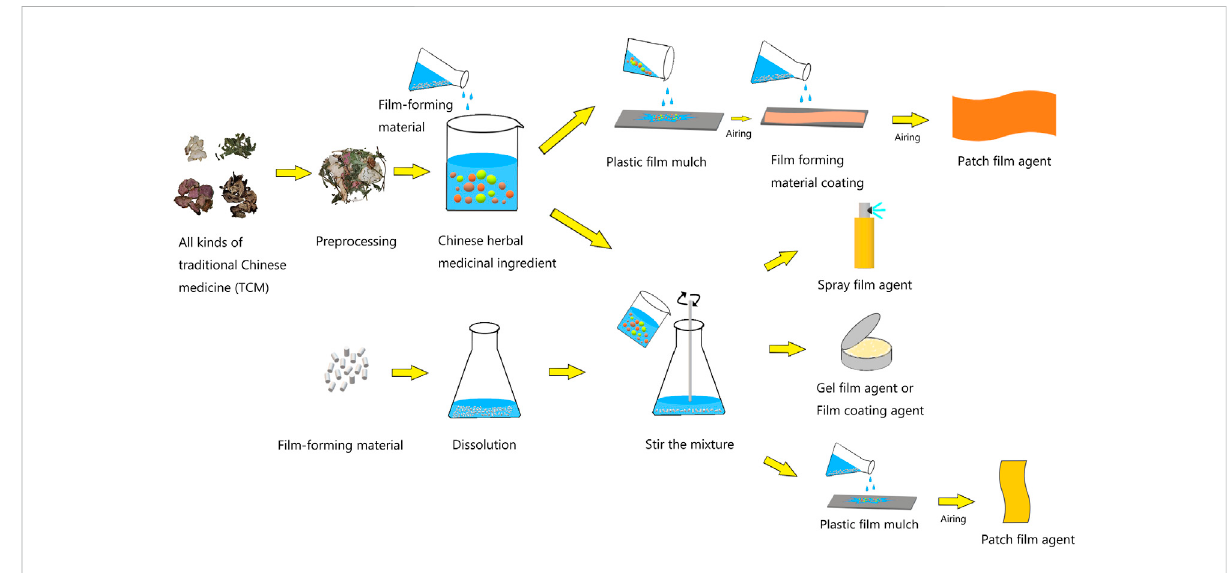
FIGURE 3 Preparation process of TCM fi lm agent.